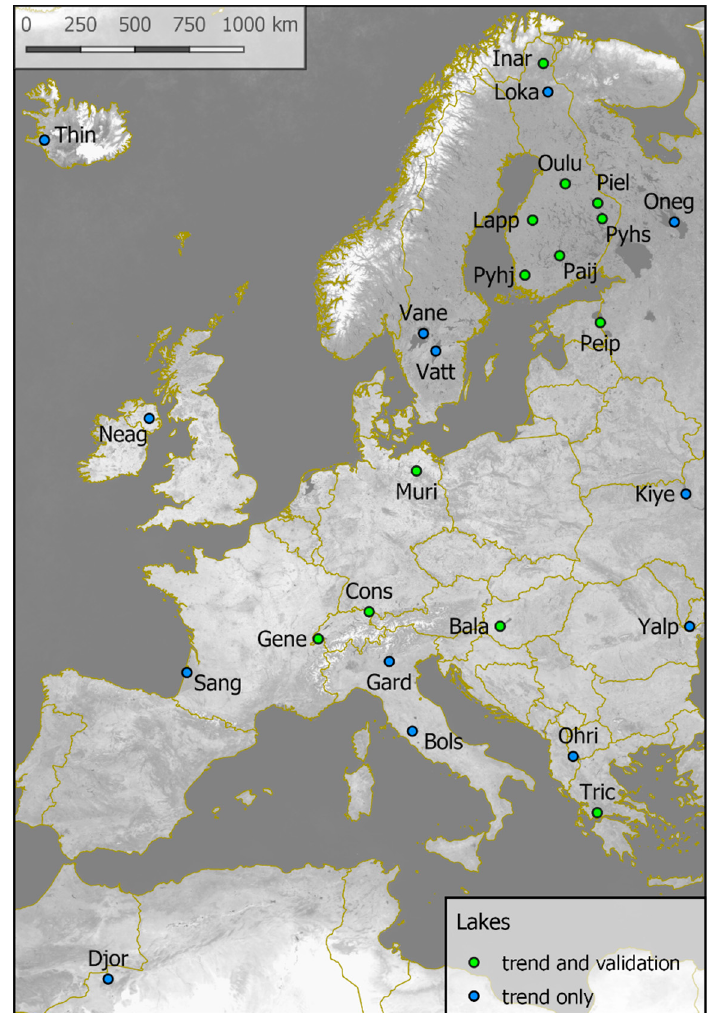
Figure 1. Advanced Very High Resolution Radiometer (AVHRR) scenes subset available within the University of Bern data archive with the lakes covered by the present study. Blue dots are all lakes for which Lake Surface Water Temperature (LSWT) data was retrieved and analysed; the green dots are the location where validation with in-situ data was performed.